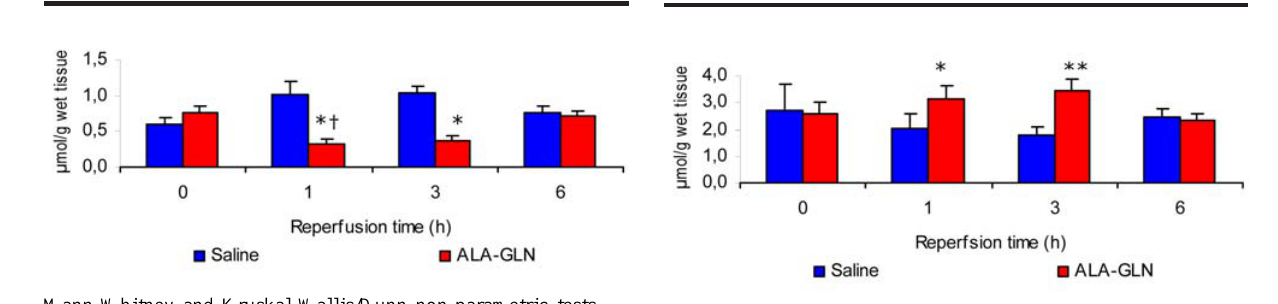
FIGURE 5 - Kidney lactate concentrations in saline and L-alanyl-glutamine treated